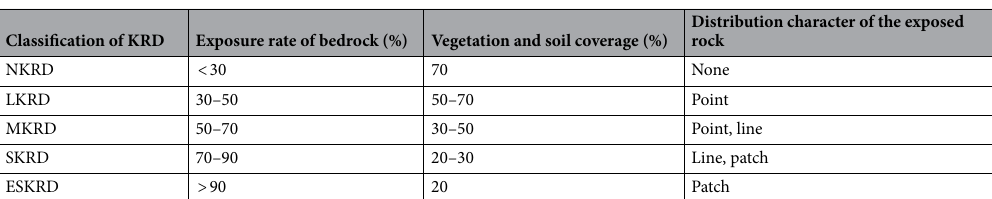
Table 7. Field classification standard for karst rocky desertification.